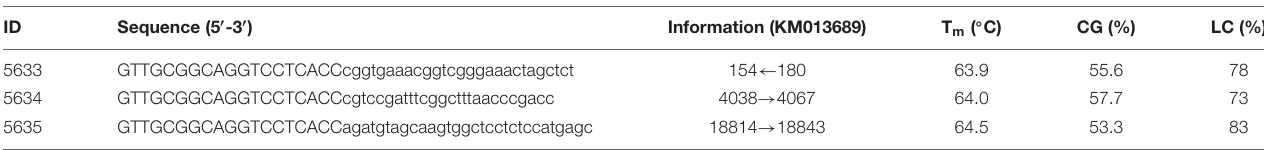
FIGURE 2 | Results of applying PST-PCR v.2 as a transposon display (TD) for Ac elements in the maize genome. Lanes represent samples of maize lines and hybrids: 1,7, A632 (PI587140); 2,8, hybrid A619 × A632 (Ames23710); 3,9, A619 (PI587139); 4,10, Mo17 (PI558532); 5,11, hybrid B73 × Mo17 (Ames19097); 6,12, B73 (PI550473). Lane M – size markers. In the first round, SSP primer 5634 ( Table 2 ) was paired with one of the PST primers (1–6: 5634-5636; 7–12: 5634-5637, Table 2 ). Primer 5600 ( Table 2 ) was used in the second round. Results of the second-round PCR detected Ac elements TD polymorphisms. TABLE 3 | Sequence-specific primers (SSPs) for the Ac transposon from Zea